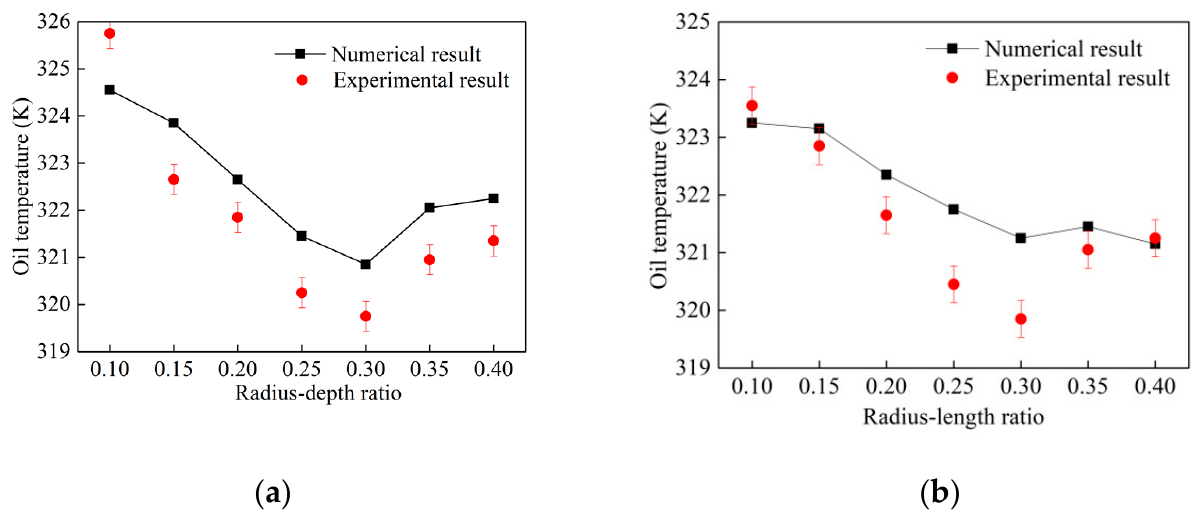
Figure 7. Comparison of the numerical results and the experimental data. ( a ) Hemispherical dimple. ( b ) Rhombus dimple.